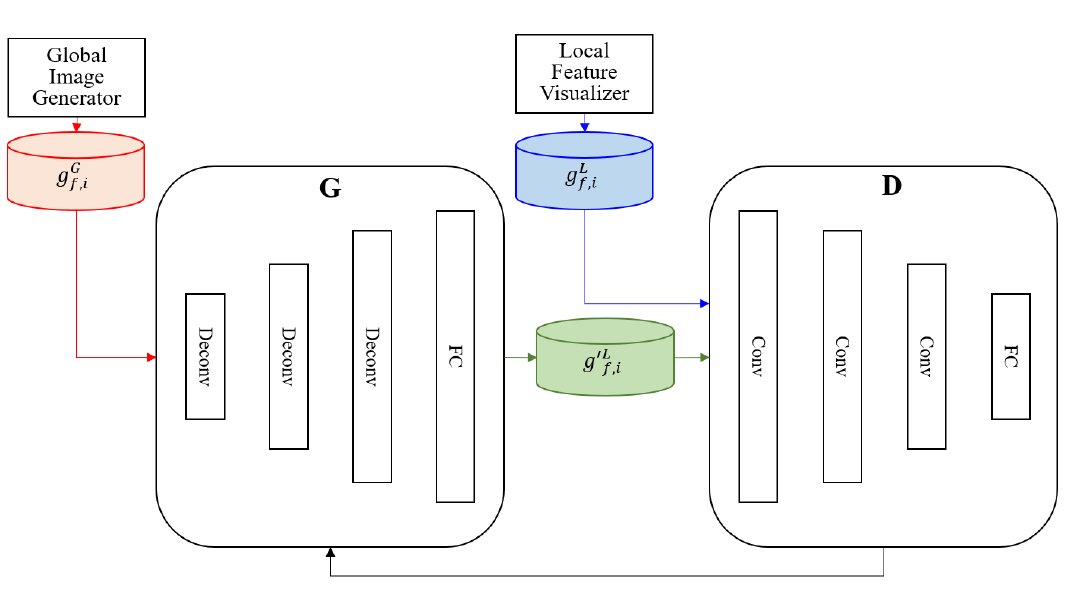
Figure 4. Global image and local image merging process. Algorithm 1 shows the image merge algorithm. 𝑆𝐼𝑍𝐸( ) is a function that returns the size of the inputted value. Ω 𝑓,𝑖 is the two-dimensional array used to create 𝑔 𝑓,𝑖𝑀 .